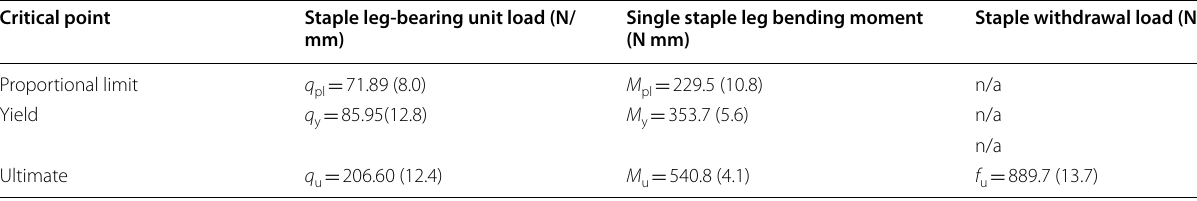
Values in parentheses are coefficients of variation in percentage